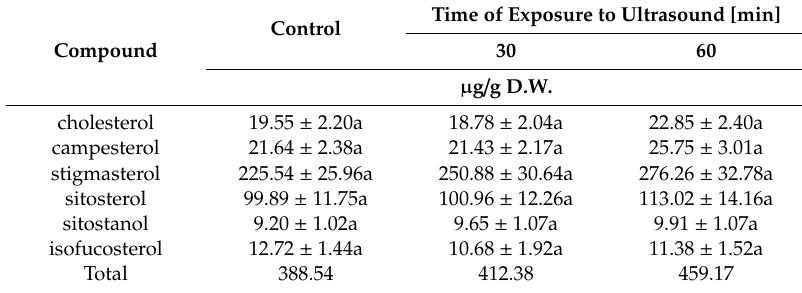
Table 7. The content of sterols in line CC16 hairy root tissue after elicitation with UV radiation. Time of Exposure to Ultrasound [min] Table 8. The content of sterols in line CH2 hairy root tissue after elicitation with UV radiation. Control Compound Time of Exposure to Ultrasound Control Compound